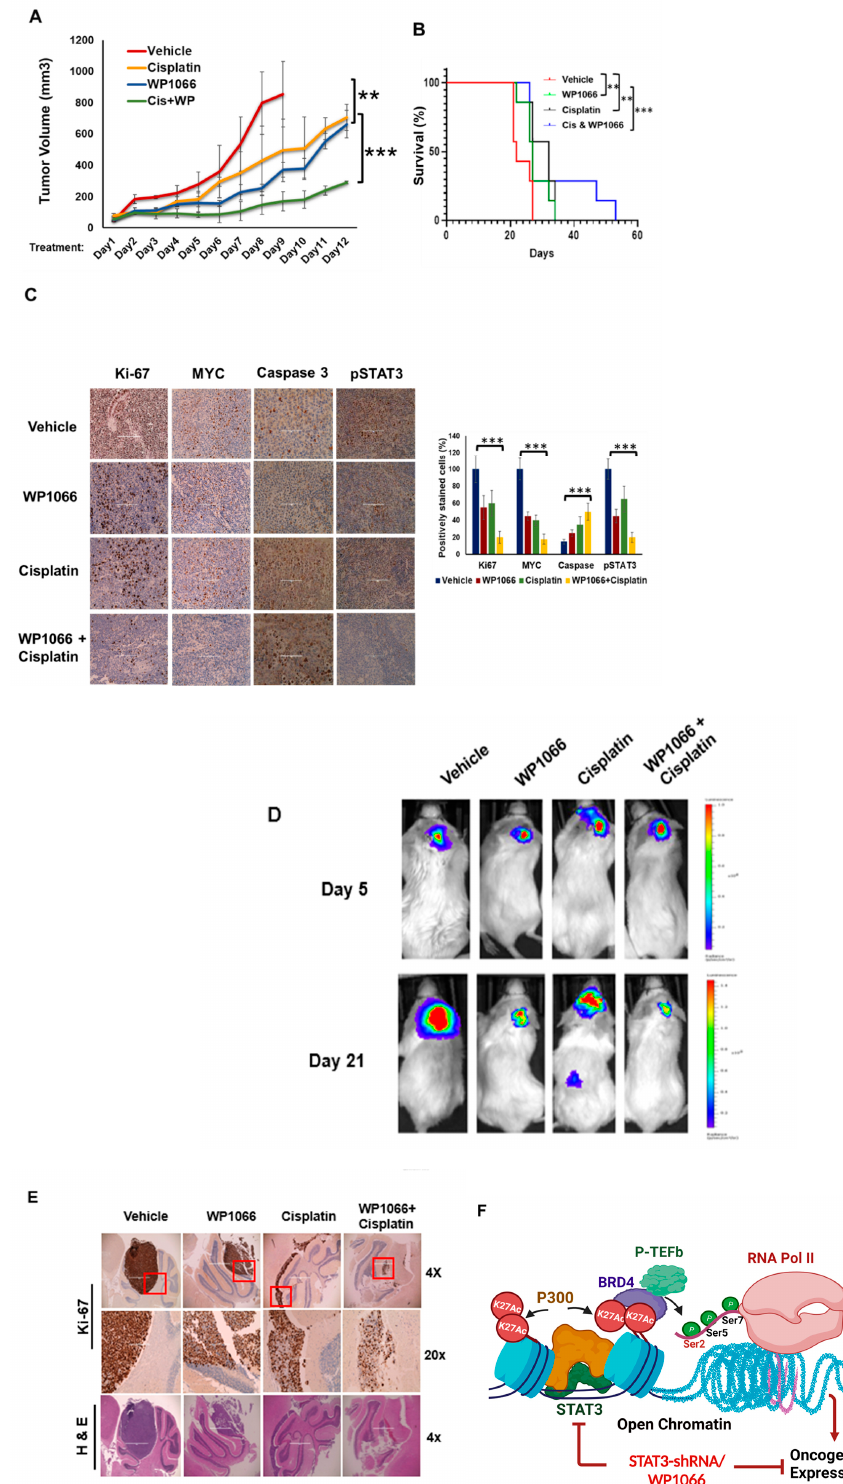
Figure 6. WP1066 a tt enuates MB tumor growth, augments chemosensitivity and mice survival. ( A ) HD-MB03 cells (0.5 × 10 6 ) were subcutaneously implanted in 5- to 6-week-old athymic nude mice. When palpable tumors were reached, treatment was initiated. WP1066 (30 mg/kg) was given 3 days a week for 4 weeks and cisplatin (2 mg/kg) twice a week for 4 weeks. DMSO (5%) was given as vehicle control. Tumor volume was measured at indicated days and tumor growth curves (Vehicle, WP1066, cisplatin and WP1066 + cisplatin) were plo tt ed. ( B ) Survival curves were plo tt ed using a Kaplan–Meier analysis. The p value was calculated using a 2-sided log-rank test. ( C ) Representative IHC images (20×) of the xenograft sections of Ki-67, caspase-3, MYC and pSTAT3 are shown. The percentages of Ki-67-, caspase-3-, MYC- and pSTAT3-positive cells derived from histology scores were quanti fi ed in the three tumor sections of each treatment group and are shown in a bar diagram. ( D ) Luciferase-expressing HD-MB03 cells were implanted orthotopically into the cerebella of NSG mice for tumor growth and the mice were treated with either WP1066 or cisplatin or the combination of both. IVIS images of representative mouse from each treatment group at day 5 (treatment started), and at day 21 (mice sacri fi ced) after implantation are shown. ( E ) H&E staining and IHC staining of cerebellar section of mice brain show the presence of tumor and proliferating cells; ** p < 0.01, *** p < 0.001 (ANOVA). ( F ) Proposed working model by which activated STAT3 and its co-regulators pro- mote oncogene expression and chemoresistance in MB and how it could be targeted by STAT3 inhi- bition.